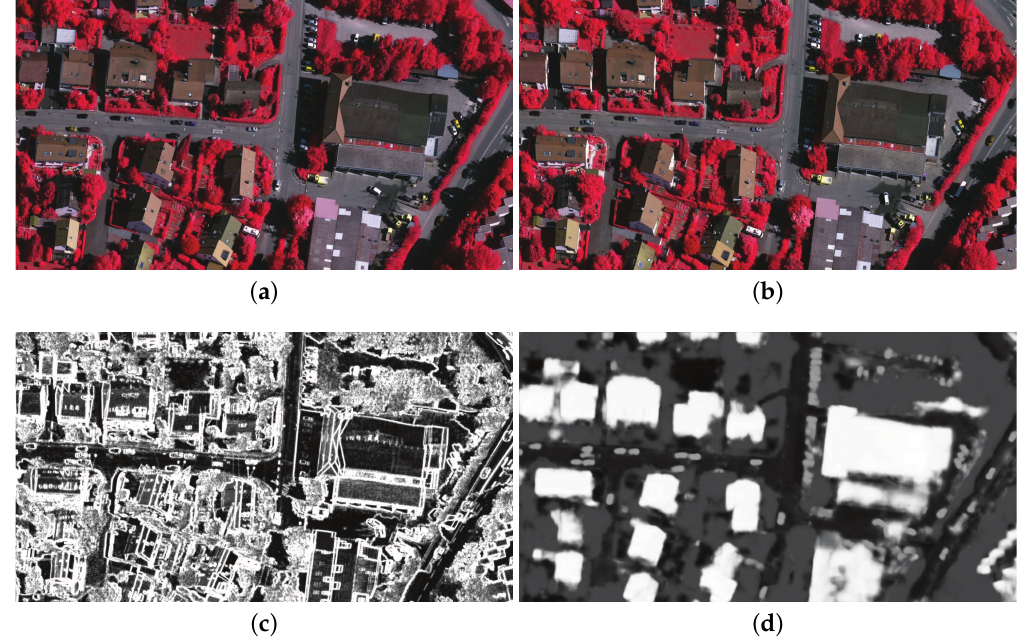
Figure 5. The comparison between the algorithm proposed by [5] and our proposed method in the term of the energy cost map: ( a , b ) the cropped regions of two input aligned images; ( c ) the energy cost map generated by [5]; ( d ) the energy cost map generated by our proposed CNN-based method. The lighter regions indicate higher energy costs in ( c , d ), where the seamline avoids to cross.